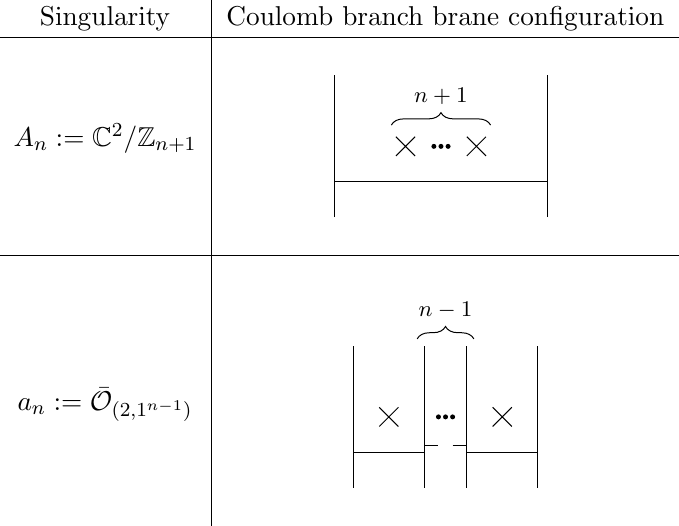
Table 1. Here we show the surface singularities A n and the minimal singularities a n in terms of branes. To obtain the complementary Higgs branch brane con(cid:12)guration just swap the D5-branes with NS5-branes and vice